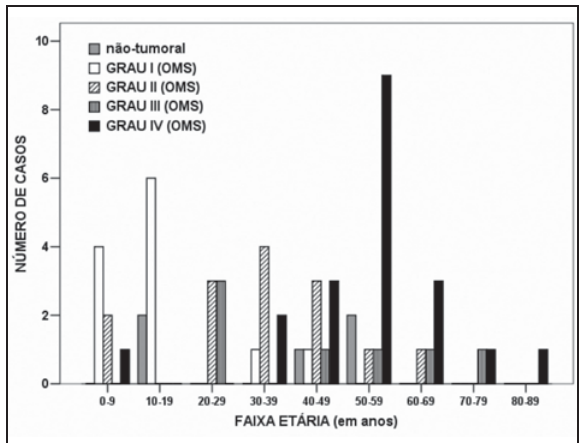
Figura 2 – Distribuição quantitativa dos casos (não-tumorais e astrocitomas) selecionados para o estudo segundo a faixa etária dos pacientes ( n = 60)